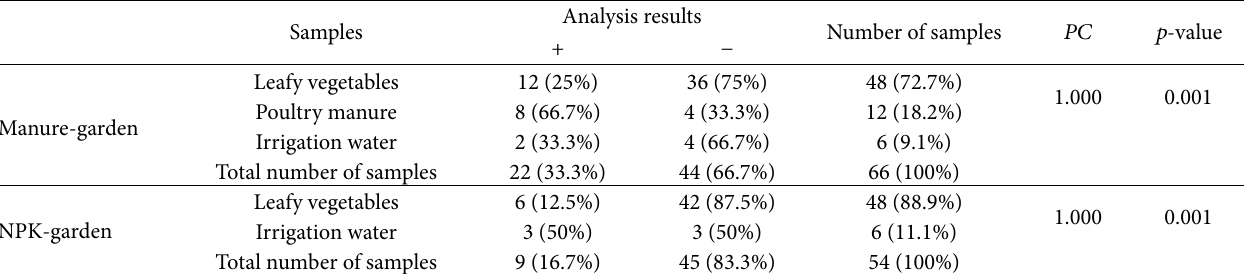
Table 3: Contamination rate of samples from Houeyiho vegetable farm.